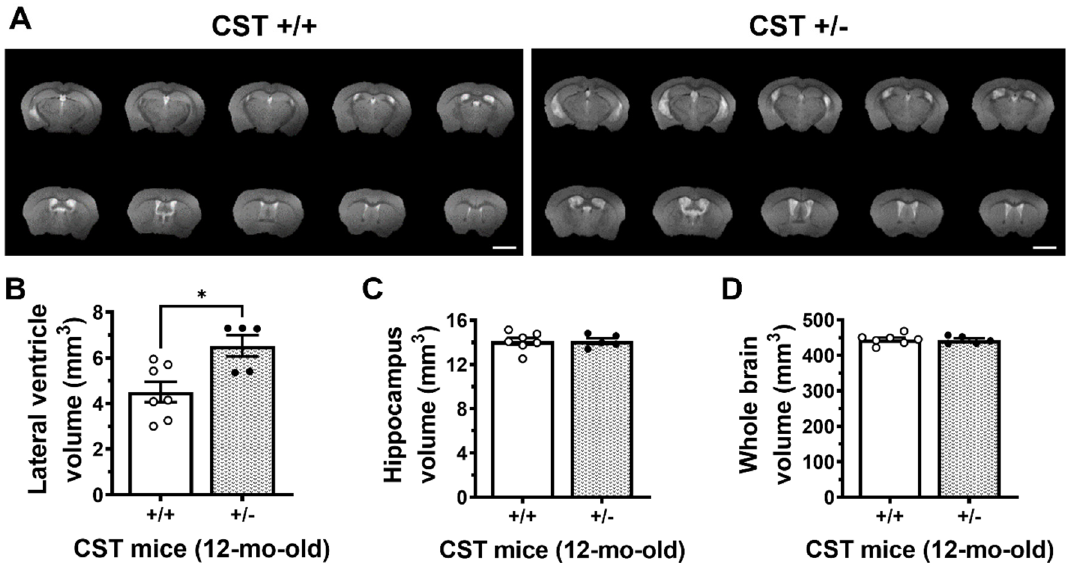
Figure 2. Enlarged brain ventricles in living sulfatide deficient mice. ( A ) Representative MRI images from CST +/+ and CST +/ − mice. White areas represent water/CSF filled ventricles. Scale bar: 2 mm. Lateral ventricle ( B ), hippocampus ( C ), and whole brain ( D ) volumes were calculated by summing ‐ up the area of each imaged section multiplied by slice thickness for each mouse brain. N = 5–7 mice/genotype. Unpaired two ‐ tailed t ‐ test (normality and equal variance were assumed/confirmed). * p < 0.05.